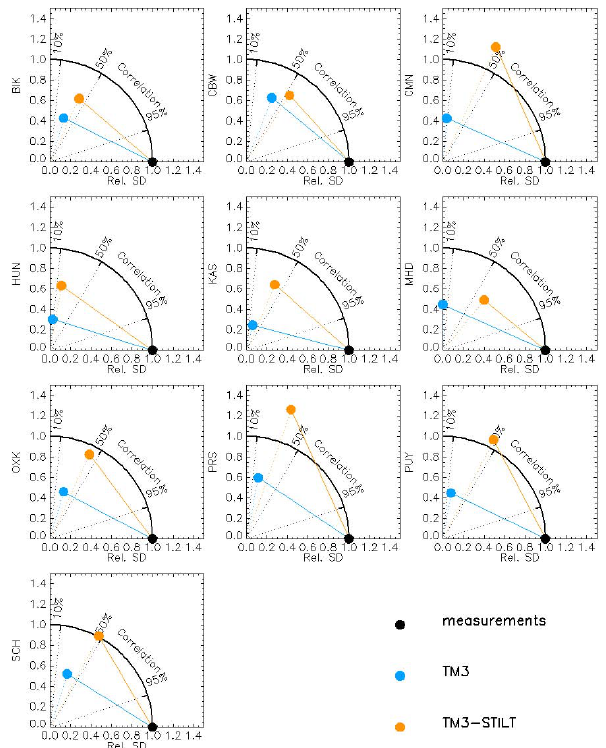
Fig. 3. Taylor diagrams for modelled and measured time series of CO 2 mixing ratio at 10 European sites. The Relative Standard De- viation (Rel. SD) was calculated as the ratio of the SD of modelled time series to the SD of observations (SD mod /SD obs ). The black point indicates the perfect match between the model and the obser-